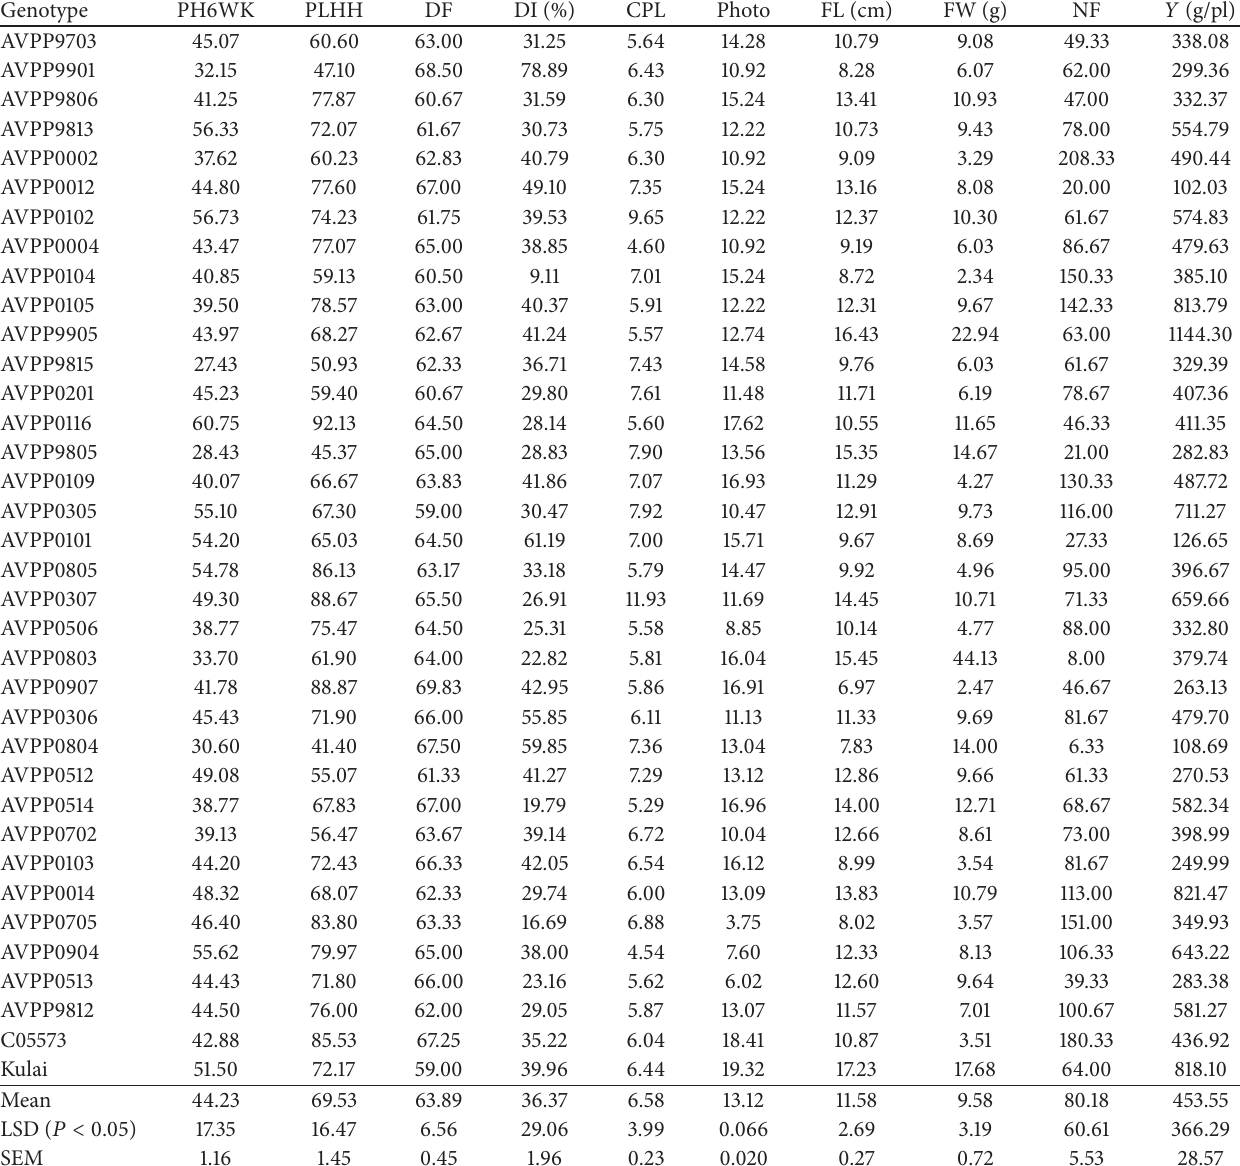
Table 5: Means for 10 characters studied in 36 genotypes of Capsicum spp